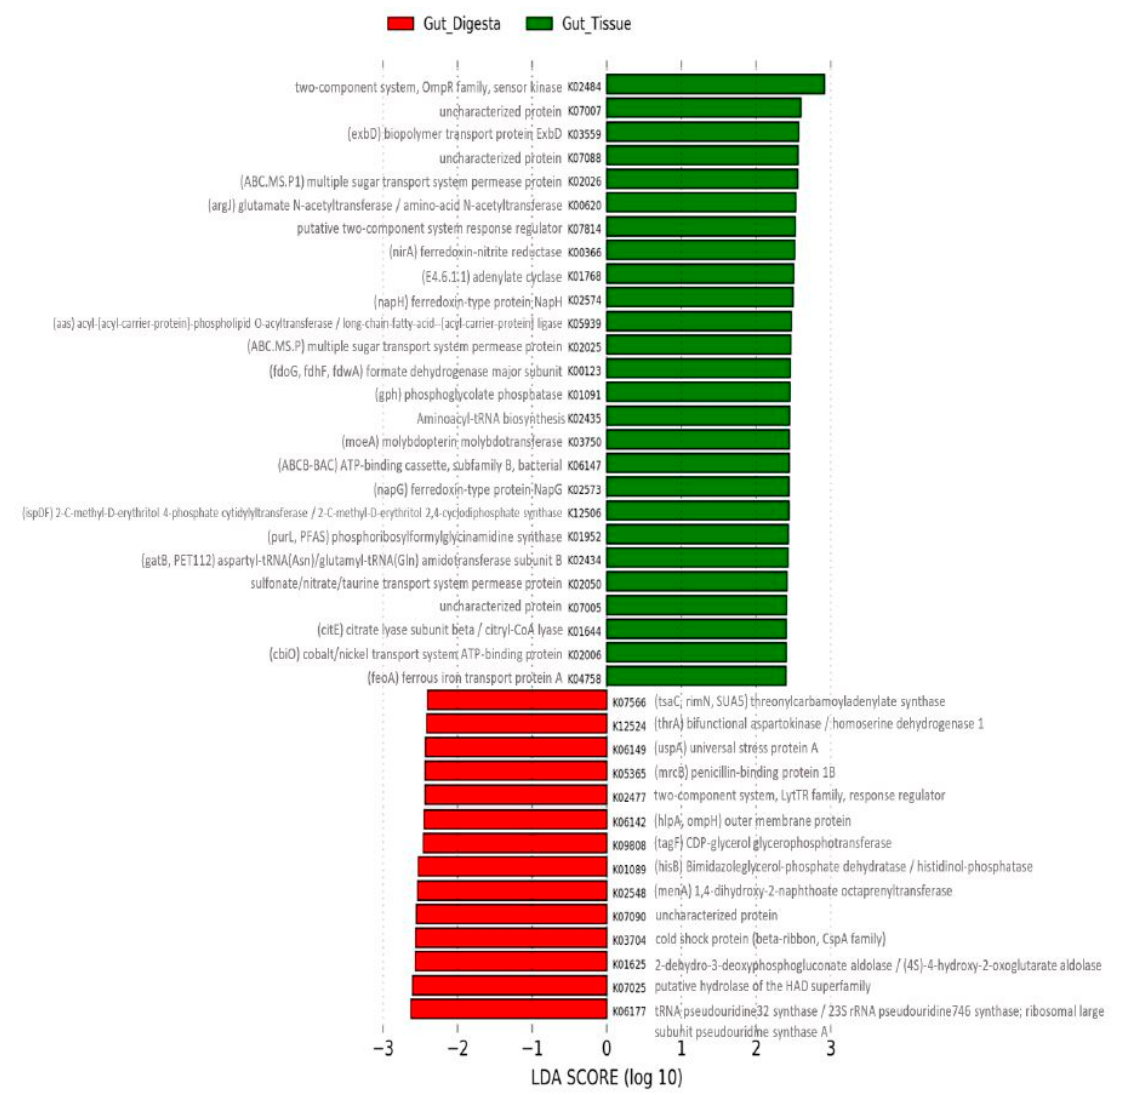
Figure 9. Linear discriminant analysis (LDA) effect size (LEfSe) performed on the KEGG Orthology (KO) metabolic functions determined through PICRUSt (v1.1.2) for the gut tissue ( n = 3) and gut digesta ( n = 3). The KO Ids were determined through the “predict_metagenomes.py” command in PICRUSt (v1.1.2). Grouped data were analyzed using the Kruskal–Wallis with a significance set to 0.05, and the significantly differentially distributed KO Ids were used for LDA model analysis ranking the relative abundance significance, at an LDA threshold showing entries ranking at ± 2.4. The log(10) transformed score is shown as the effect size. Data were analyzed and prepared through Hutlab Galaxy provided through the Huttenhower lab. The gut tissue group is shown as green, and the gut digesta group as red. The KO Id labels have been generated using scalable graphics, and therefore regions of interest can be viewed at a higher resolution digitally by increasing the